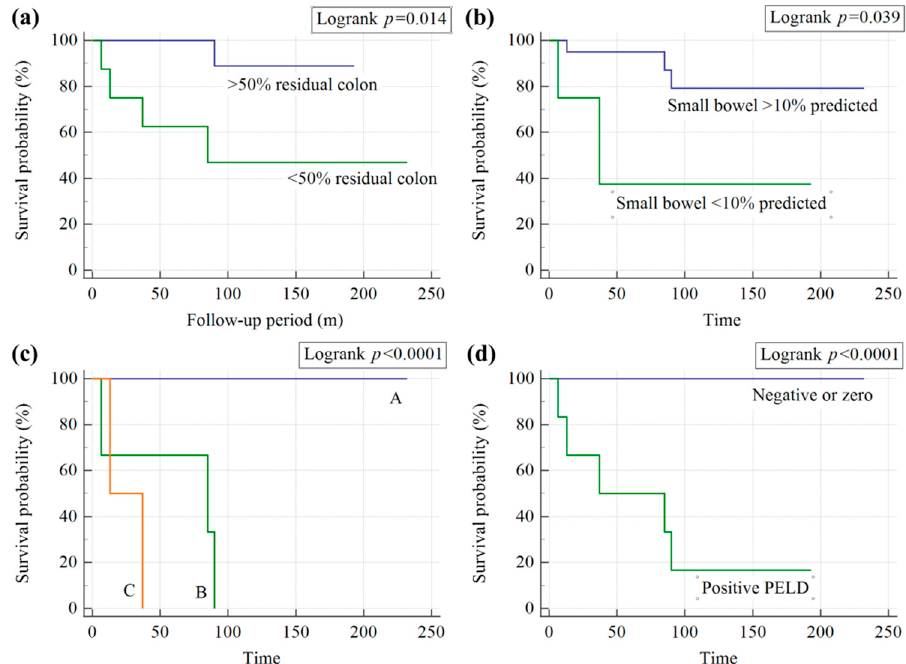
Figure 3. Kaplan–Meier estimated survival rates of pediatric patients with HPN, considering the different risk factors: ( a ) major colon loss (>50%), ( b ) residual small intestine length <10% predicted,